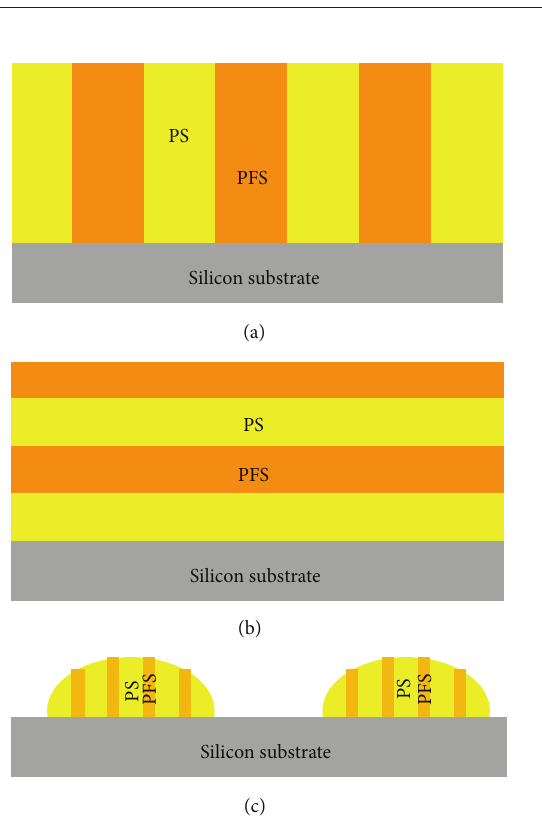
Table 2: Static water contact angle within experimental error ( ± 2) for PS, PFS, and substrates with various chemistries. Surface type PS/Si PFS/Si Graphene Contact angle, ∘ 112.0